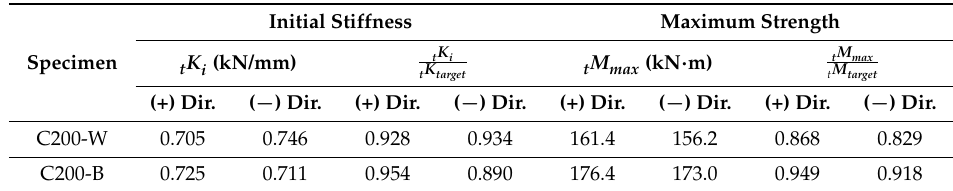
Table 10. Comparison of a ceiling bracket size and a shape.